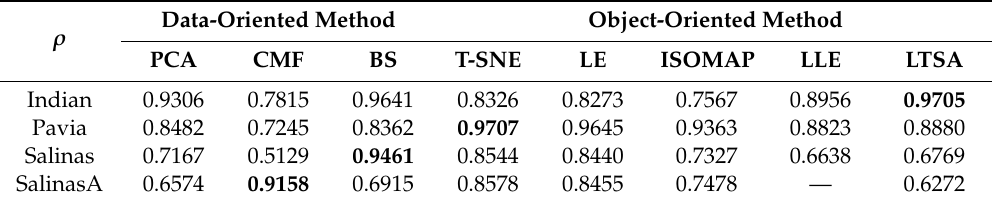
Table 2. The correlation of the original data ( ρ ).